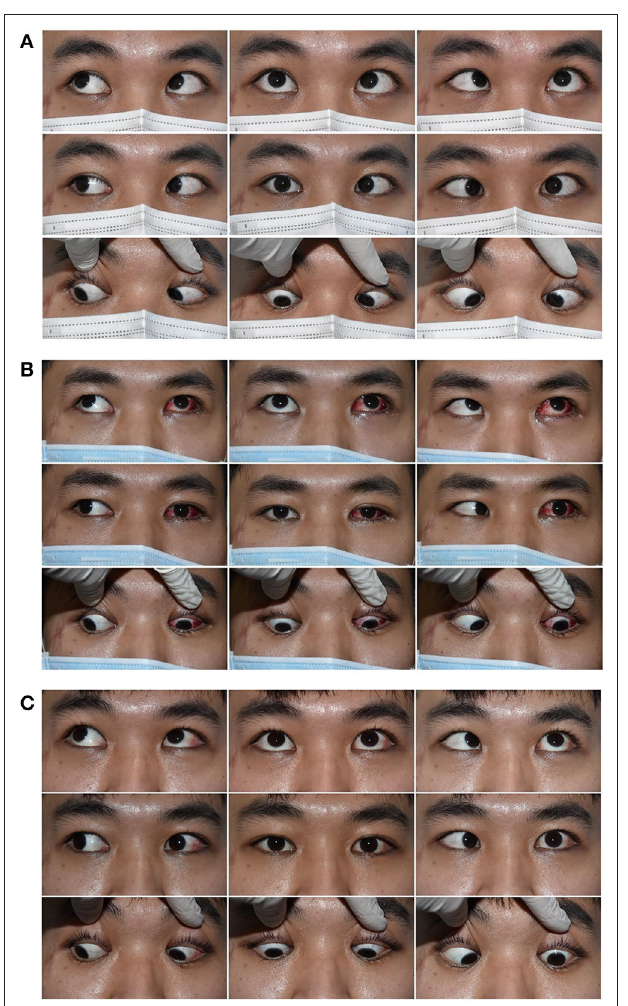
FIGURE 3 | Typical case 1 showed the patient with abduction = − 4 on the last visit. A 24-year-old male whose left eye deviated inward for 10 months after an injury resulting from a fall. He was diagnosed as a complete traumatic abducens nerve palsy and received a medial rectus recession of 10mm and lateral rectus resection of 13mm in his left eye while under general anesthesia. The FDT performed during surgery was negative. (A) The patient’s 9-gaze eye position photo is shown preoperatively with left eye esotropia 50PD (LET = 50PD), abduction-6, adduction + 1. (B) 1 day postoperatively with left eye exotropia 30PD (LXT = 30PD), abduction-2, adduction-4. (C) 2 months postoperatively with esotropia 3PD (ET = 3PD), abduction-4, adduction-2.